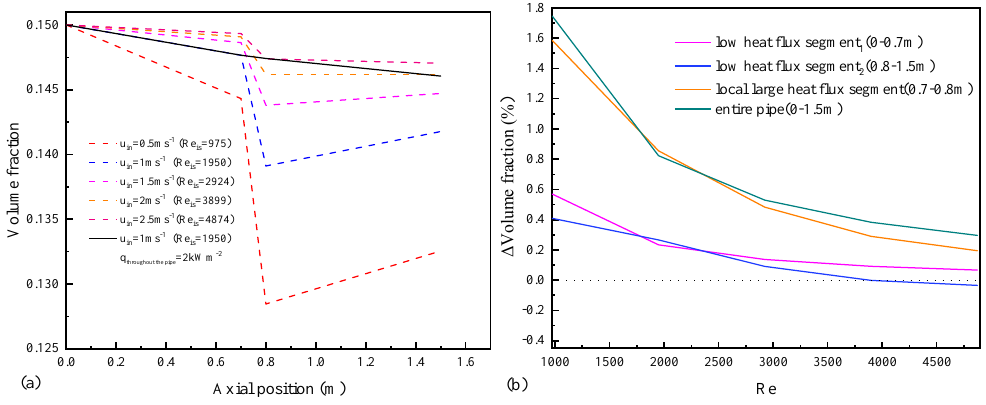
Figure 9. ( a ) Axial evolution of IVF ( b ) ΔIVF of each segment with different Re is .